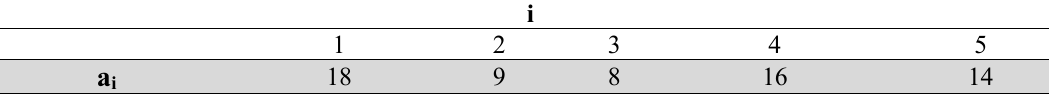
Required resource for each project